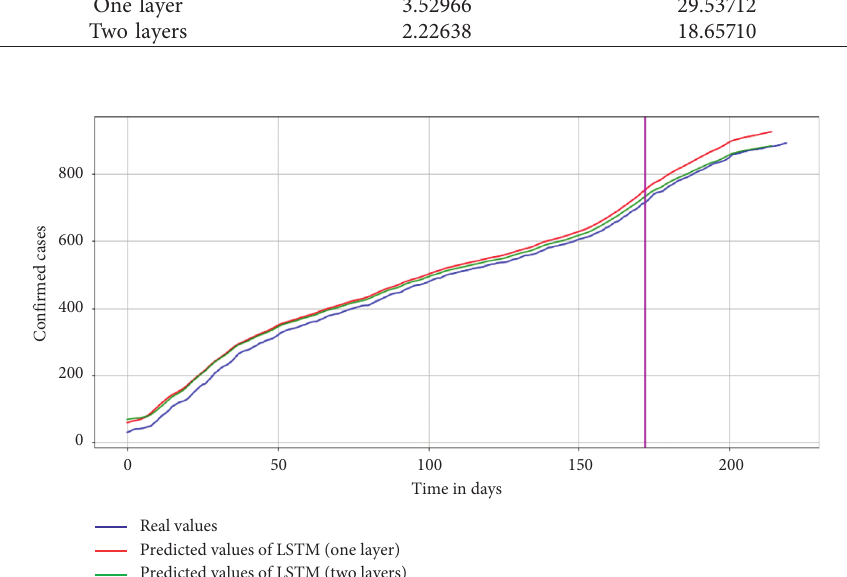
Figure 12: Comparison between real death cases and the predicted death cases for LSTM (Kuwait).